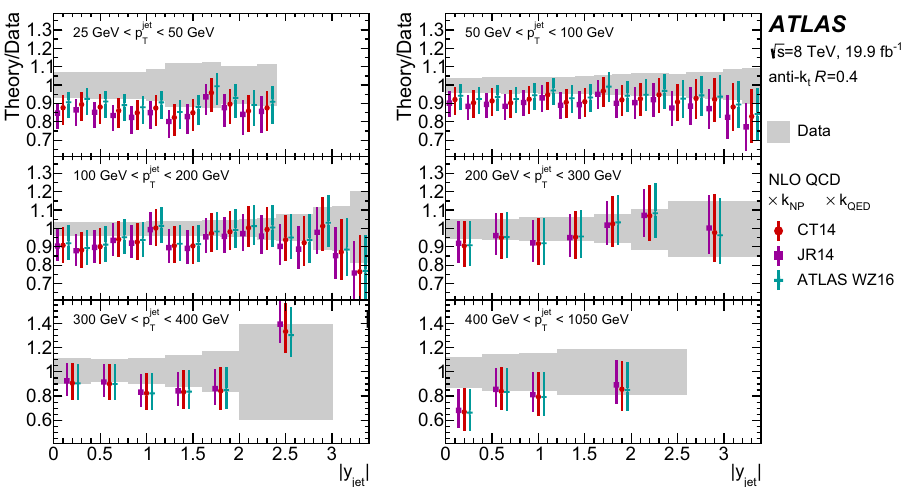
Fig. 15 Ratio of the measured Z + jets production cross-section and the NLO QCD predictions, obtained using MCFM, corrected for the non-perturbative and QED radiation effects as a function of | y jet | and p jet bins. Theoretical predictions are calculated using various PDF sets. T The coloured error bars represent the sum in quadrature of the effects